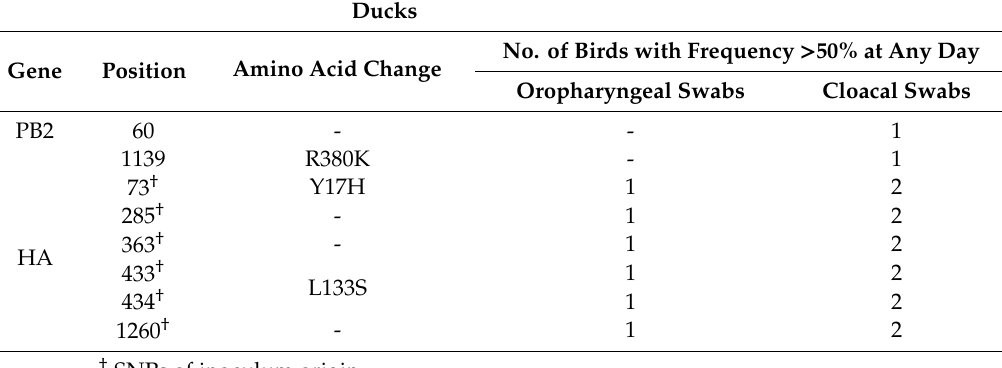
Table 4. Changes in the consensus sequences in samples collected from ducks infected with A / turkey / Poland / 14 /